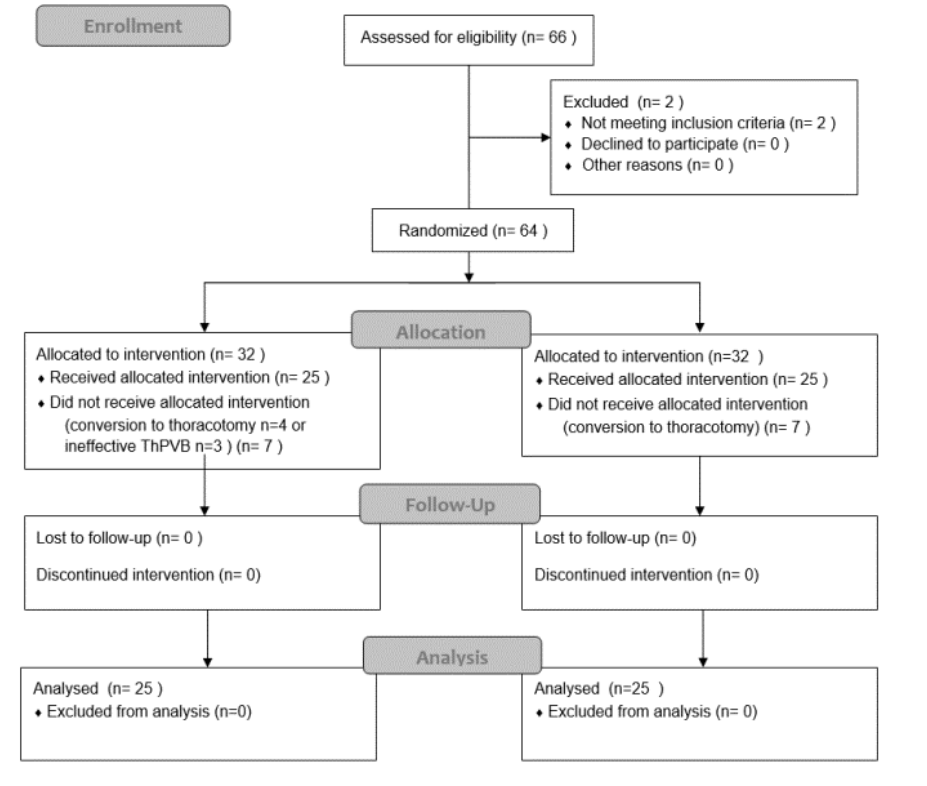
Figure 1. Consort flow diagram. Table 2. Comorbidities in the study groups. Table 1. Demographic and main patient characteristics.